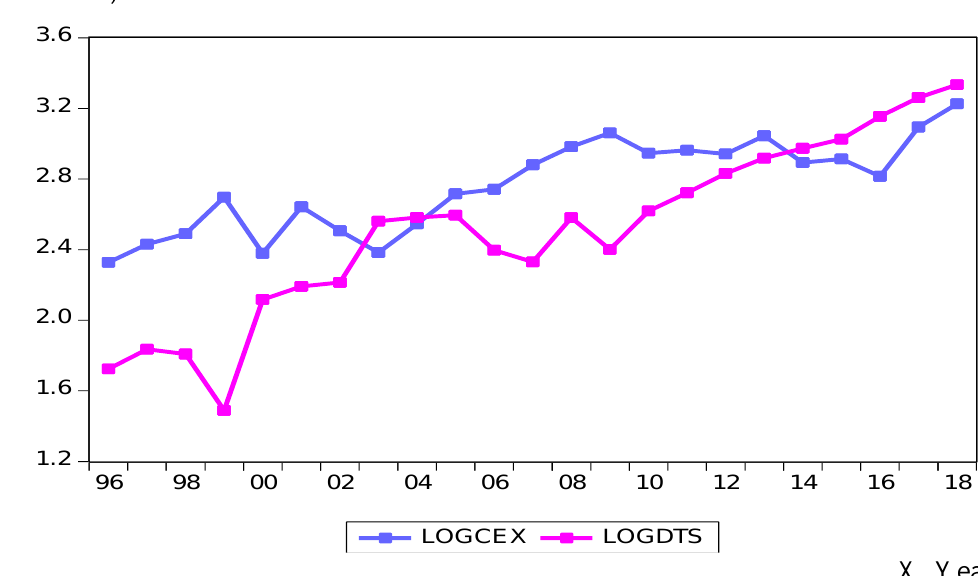
Fig. 3. Data trends from 1996 to 2018 (Central Bank of Nigeria Statistical Bulletin,